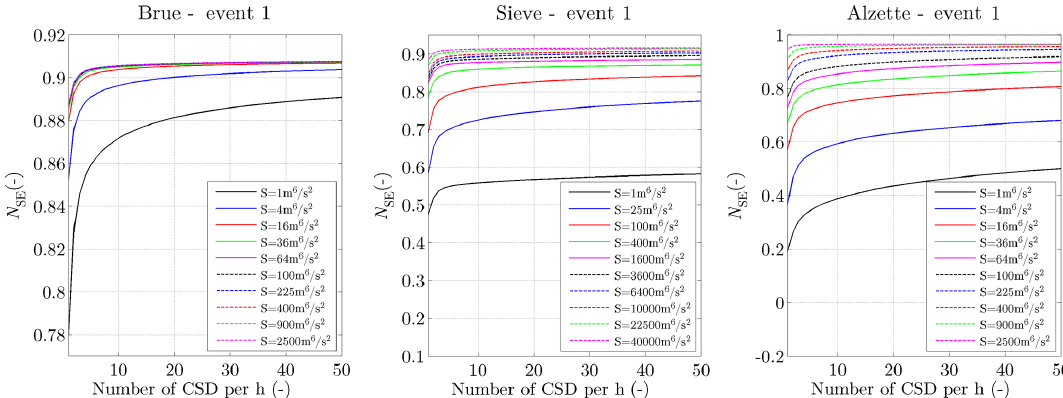
Figure 8. Model improvement in terms of Nash–Sutcliffe efficiency ( N SE ) , during flood event 1 for each case study, for different values of the model error matrix S and 24h lead time, assimilating streamflow CSD according to scenario